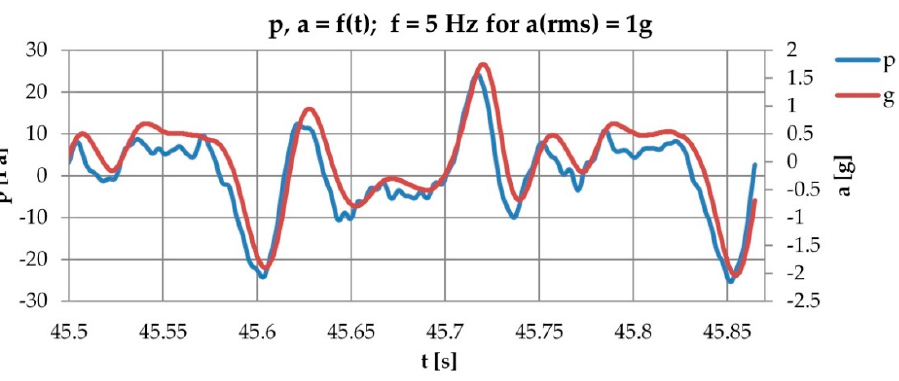
Figure 4. Dependency chart of p = f (t), forcing signal “ a ” on the frequency of 40 Hz and acceleration 1 g, and the response of the sensor, curve “p” [25,26] .